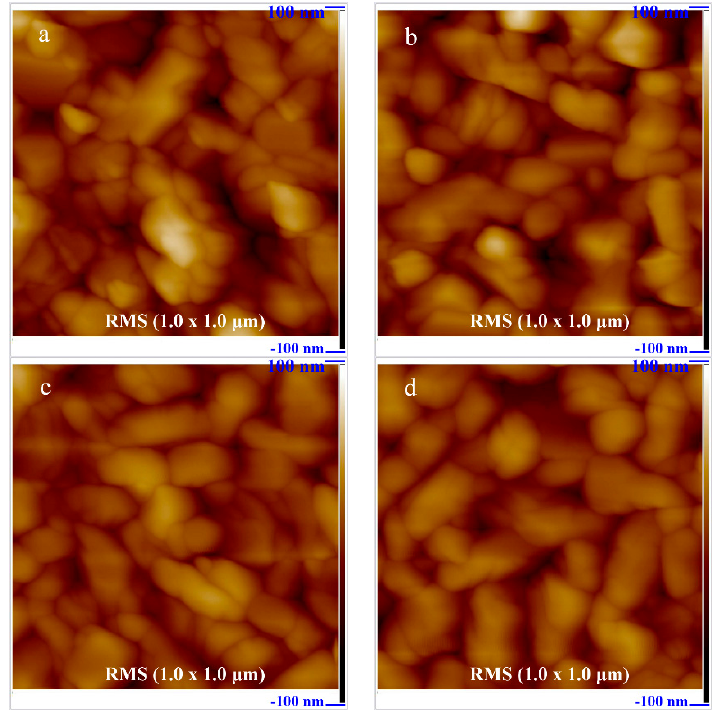
Figure 3. Atomic force microscopy (AFM) two-dimensional (2D) images of the surface morphologies of the CuCr 1 − x Zn x O 2 films for x = ( a ) 0, ( b ) 0.025, ( c ) 0.065, and ( d ) 0.085.